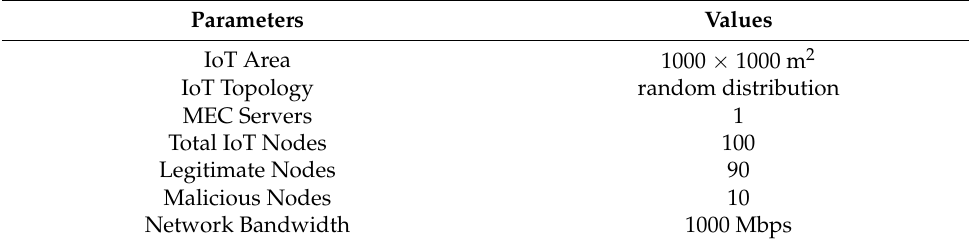
Table 1. Simulation